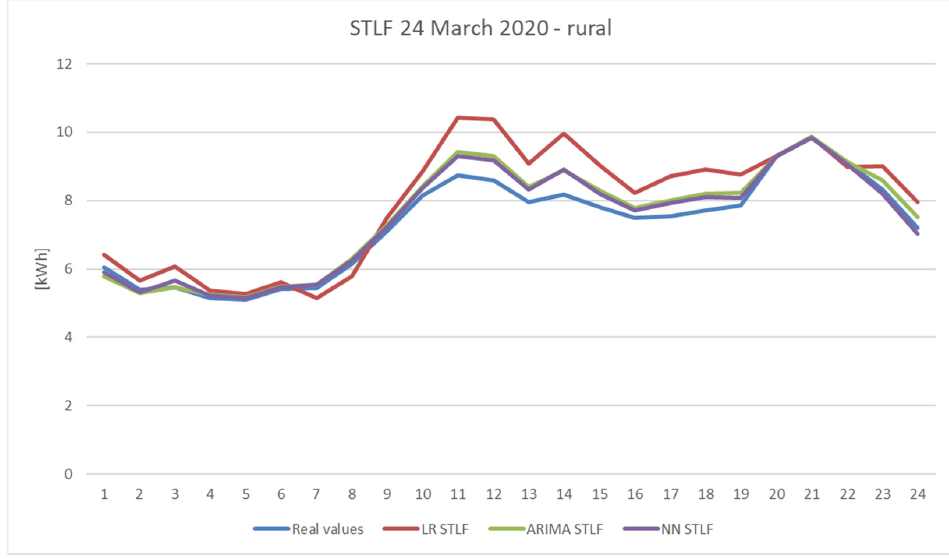
Figure 12. STLF results for 24 th March 2020—rural consumers without the adapted algorithm.